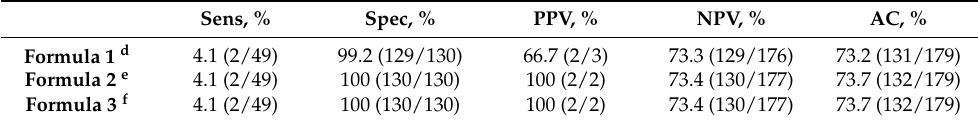
Table 4. Sequence-combined diagnostic performance of PHHE-FOCUS signs for A-AAS. Sens, % Spec, % PPV, % NPV, % AC, % Formula 1